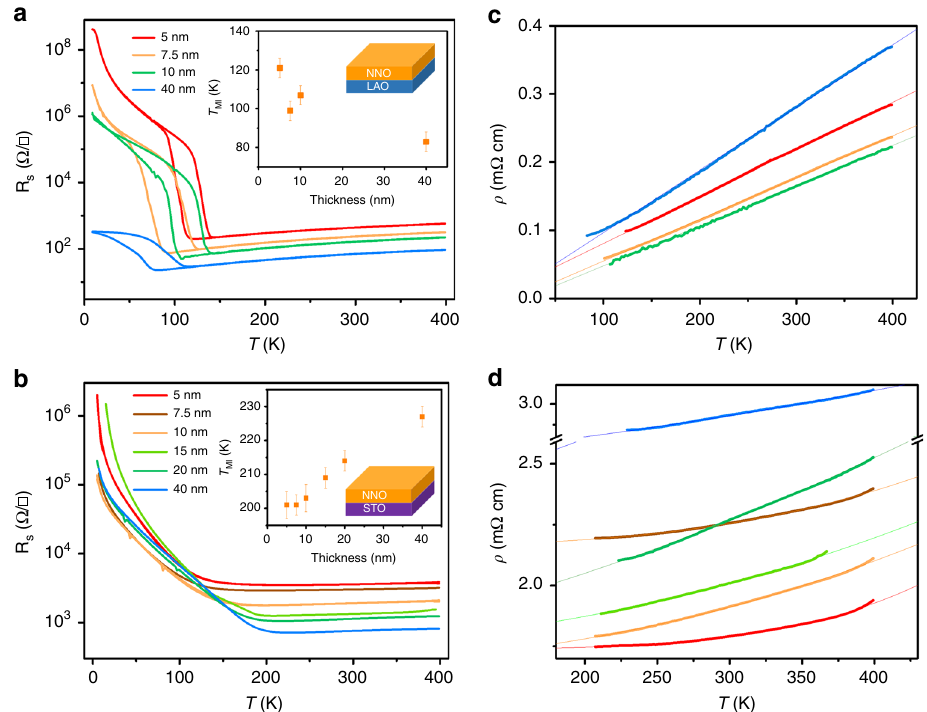
Fig. 1 Temperature-dependent resistivity. Temperature dependence of the sheet resistance ( R S ), both during cooling and heating for NNO thin fi lms grown on a LAO and b STO substrates with different thickness. The inset shows the metal – insulator transition temperature ( T MI ) as a function of thickness. The T MI is extracted from the resistivity data during the cooling-down process. The resistivity as a function of temperature in the metallic phase of NNO thin fi lms grown on c LAO and d STO substrates with different thickness. The thin solid lines are fi ts using Eq.